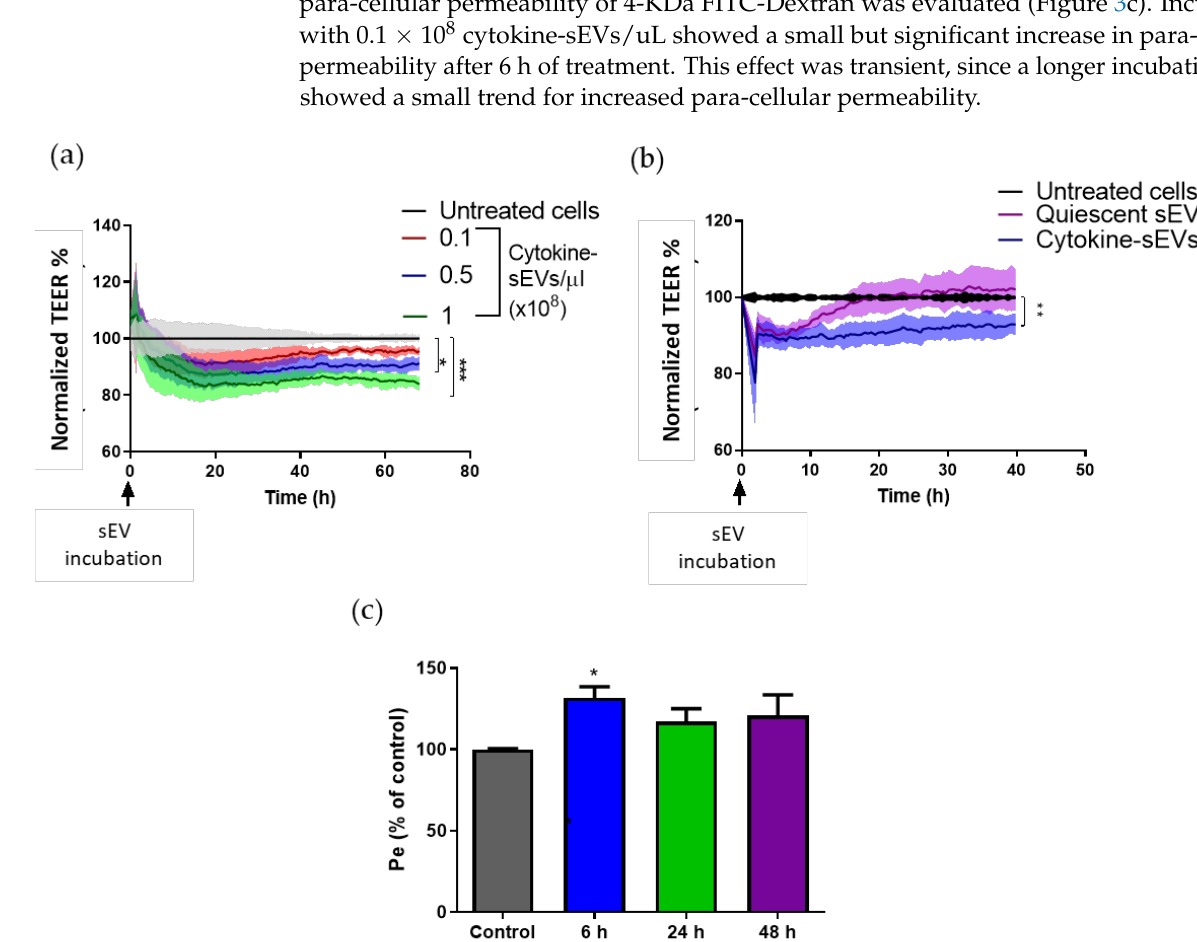
Figure 3. Cytokine-sEVs decrease the transendothelial resistance of hCMEC/D3 cells. ( a ) TEER values following hCMEC/D3 cells with varying concentrations of cytokine-derived small EVs (cytokine-sEVs) (0.1, 0.5 and 1 × 10 8 sEVs/ µ L). Data are shown as the percentage fold change of treated relative to untreated cells at each time point. ( b ) Comparison of the effects of 0.5 × 10 8 sEVs/ µ L cytokine-sEVs and quiescent sEVs on the TEER values. ( c ) Para-cellular permeability experiment of 70-KDa FITC-Dextran after a 0.1 × 10 8 cytokine-sEVs/ul stimulation for 6, 24 and 48 h. Data is shown as the mean ± SEM. The means are compared by two-way ANOVA followed by Tukey’s post-hoc for multiple comparisons, n = 3 ( b ) and 4 (a). * p < 0.05, ** p < 0.01, *** and p < 0.001 compared to untreated cells.